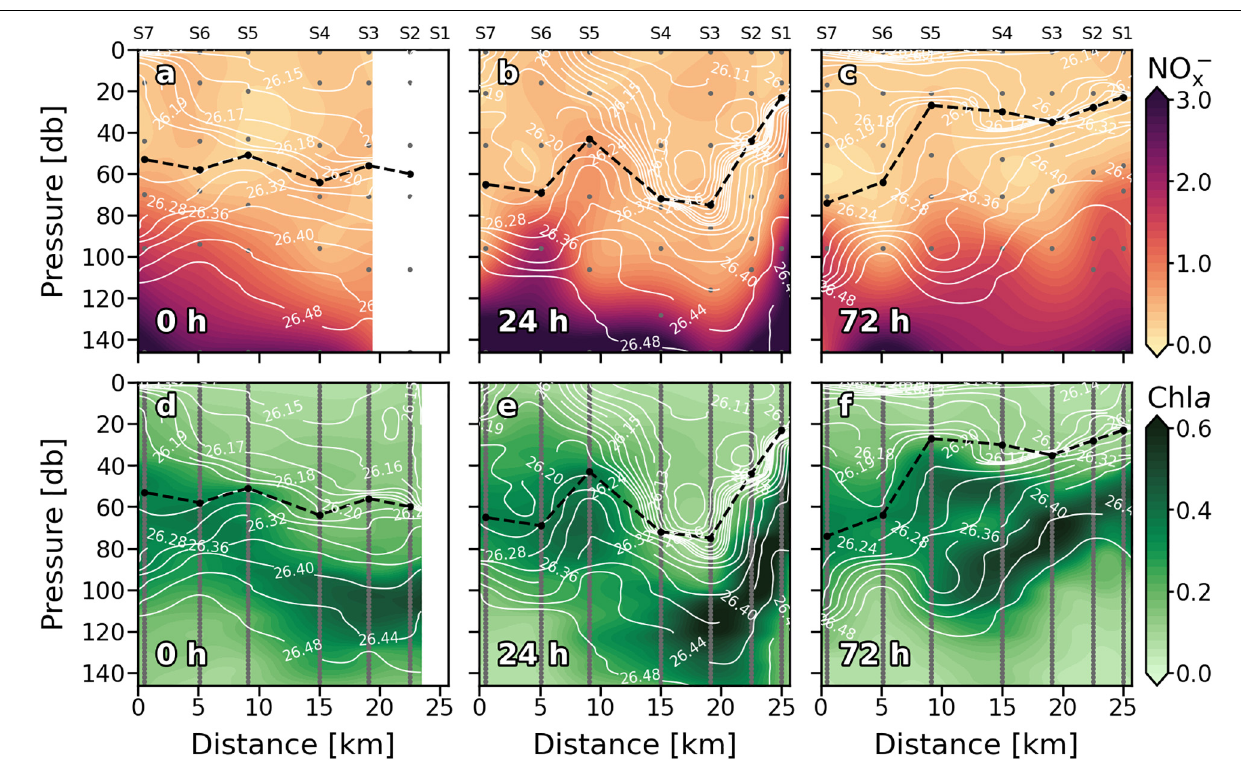
FIGURE 4 | Vertical sections of nitrate + nitrite (NO x − ) (mmol · m − 3 ) (a–c) , and chlorophyll a (Chl a ) (mg · m − 3 ) (d–f) for every sampling day. Stations are indicated in the upper part of the plot. Isopycnal field is superimposed as solid white lines. Dashed black line indicates the mixed layer depth. Sampling depths are represented by gray